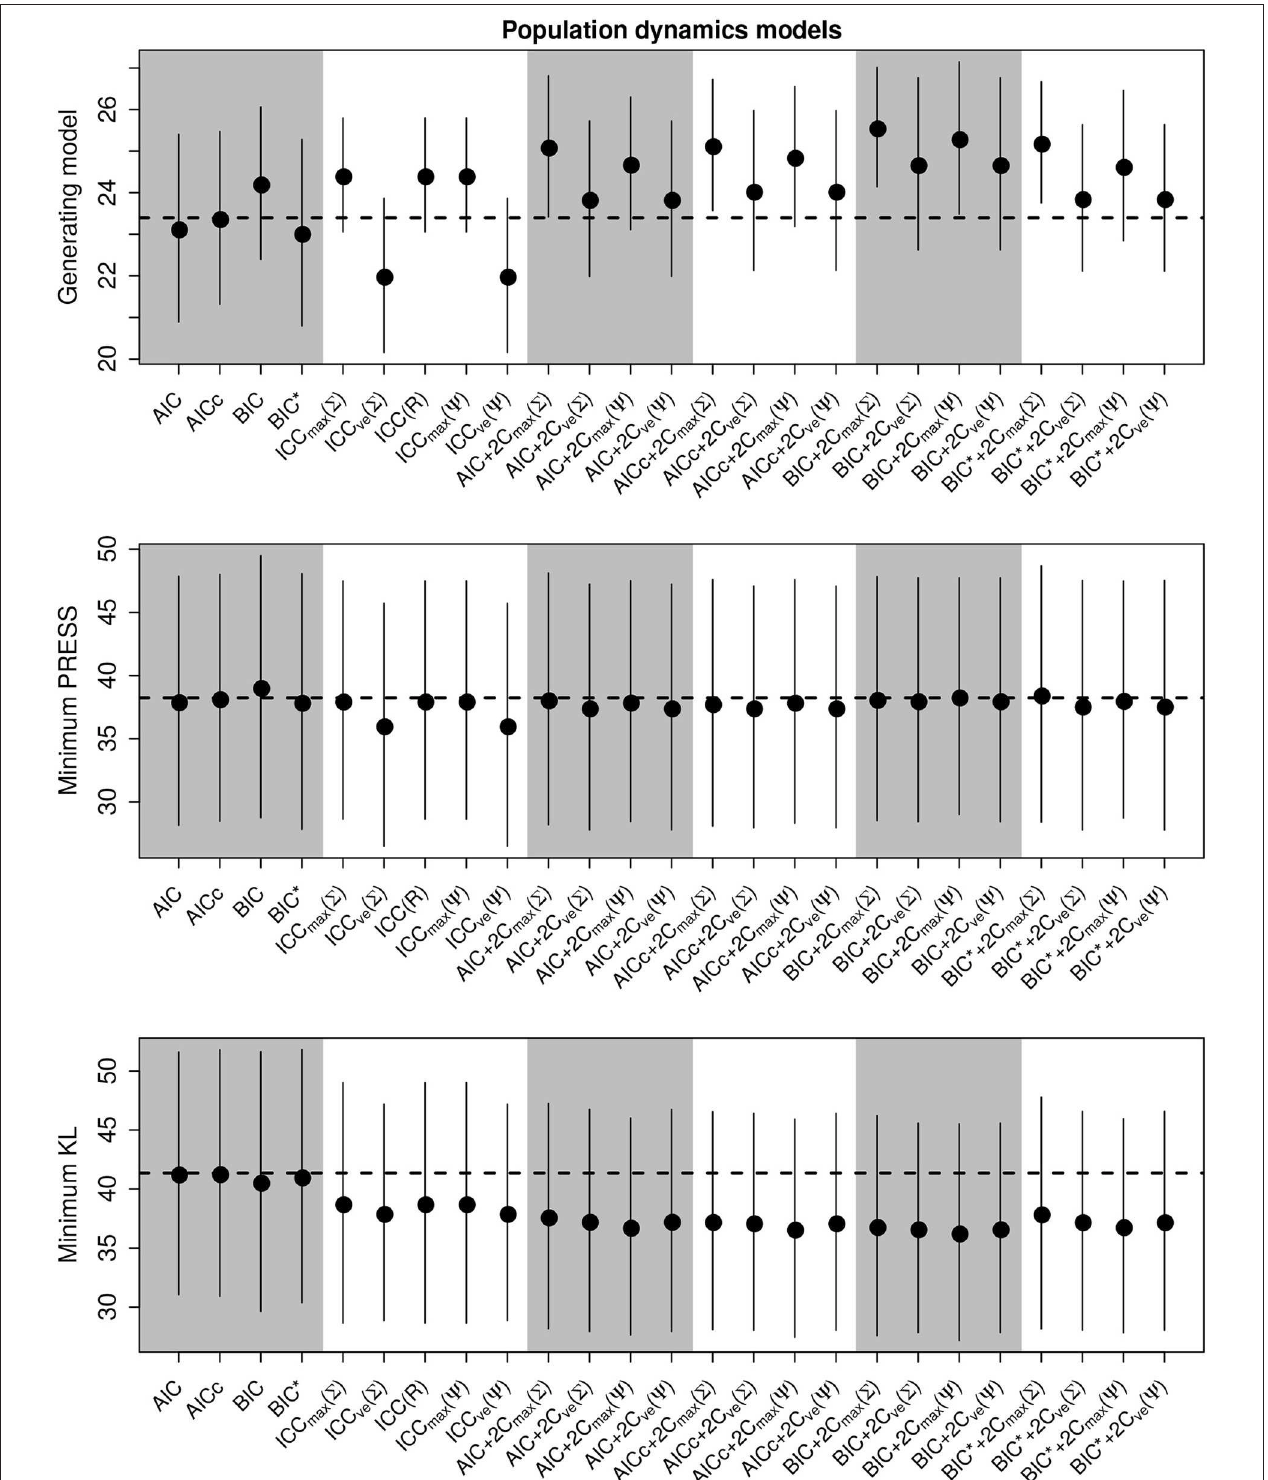
FIGURE 3 | Performance of the criterion for all selection goals for the nonlinear population dynamics model simulation experiment. Points are the average performance-level, bars give standard errors. The top panel gives the frequency that each criterion selects the model used to generate the data, the middle pannel gives the frequency of selecting the model that minimizes the predicted residual error sum of squares (PRESS), while the bottom panel gives the frequency of selection by the criterion of the model corresponding to the minimum Kullback-Leibler divergence (KL).